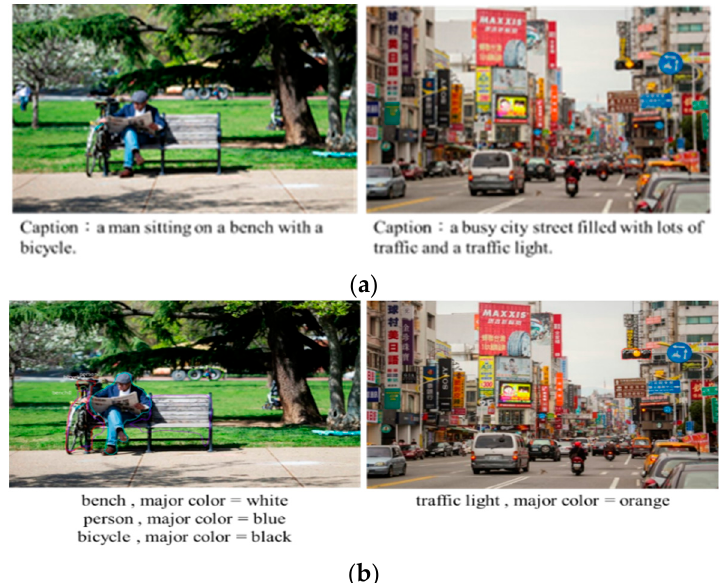
Figure 14. Processing results: ( a ) image captioning; ( b ) object recognition.